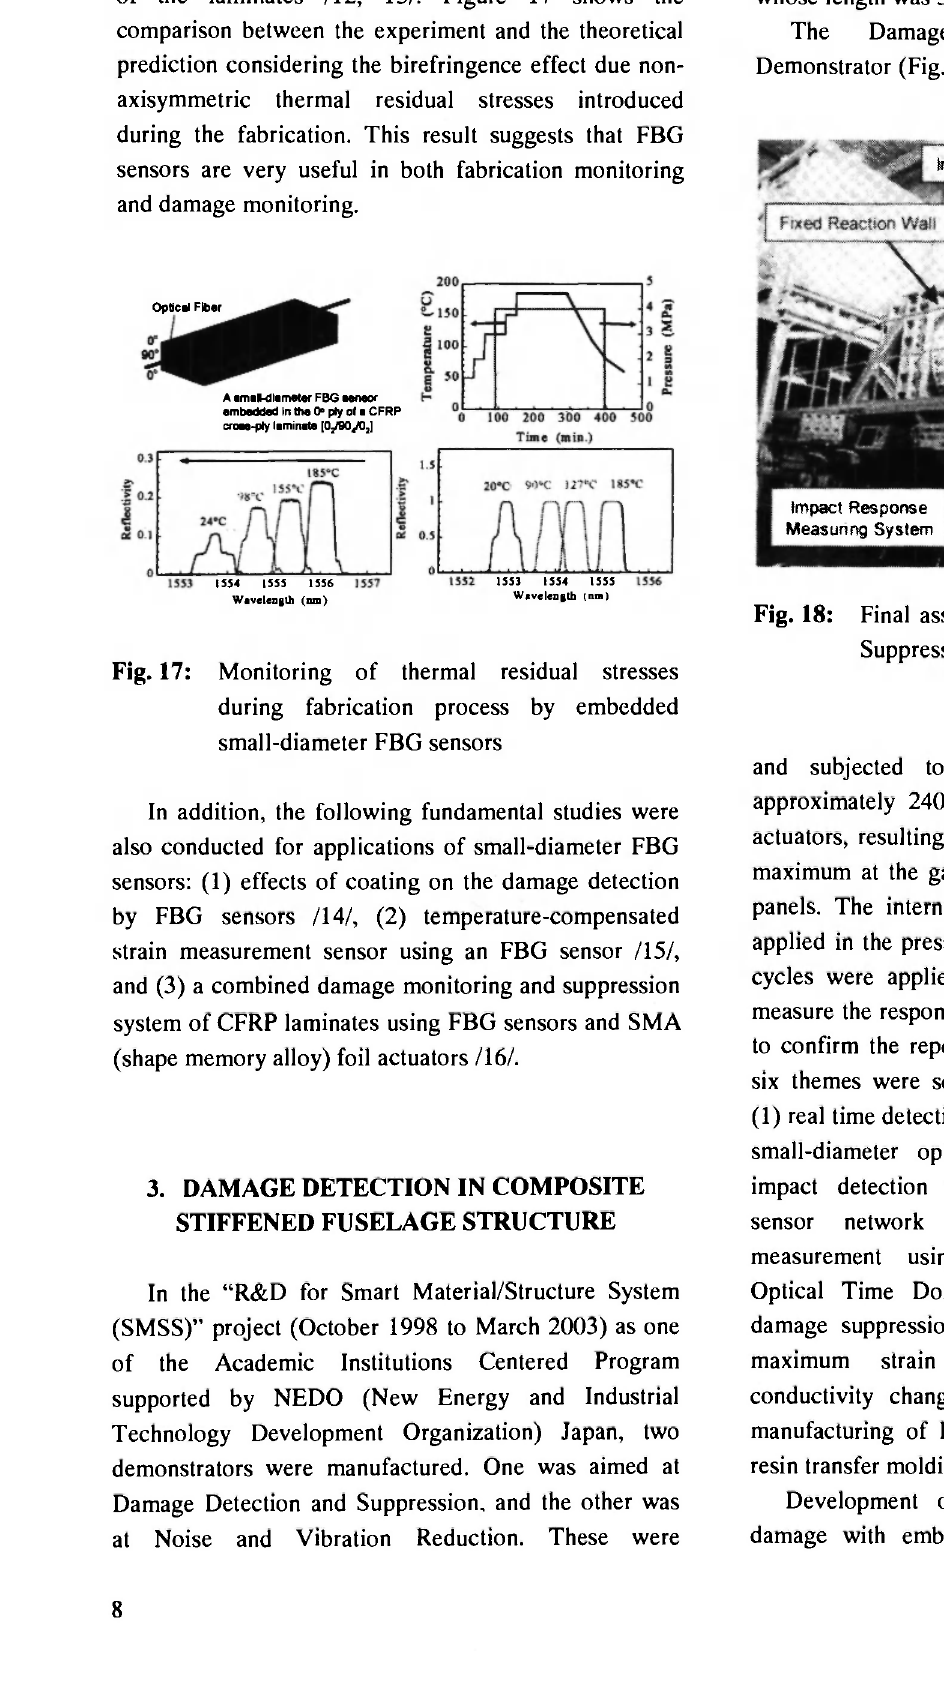
Fig. 17: Monitoring of thermal residual stresses during fabrication process by embedded small-diameter FBG sensors